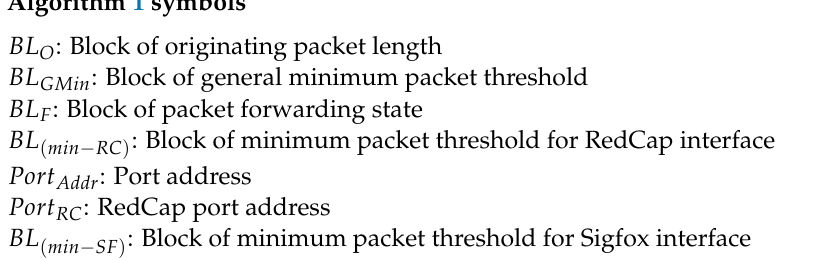
Algorithm 1 Explanation: The block of originating packet length, BL O , initializes